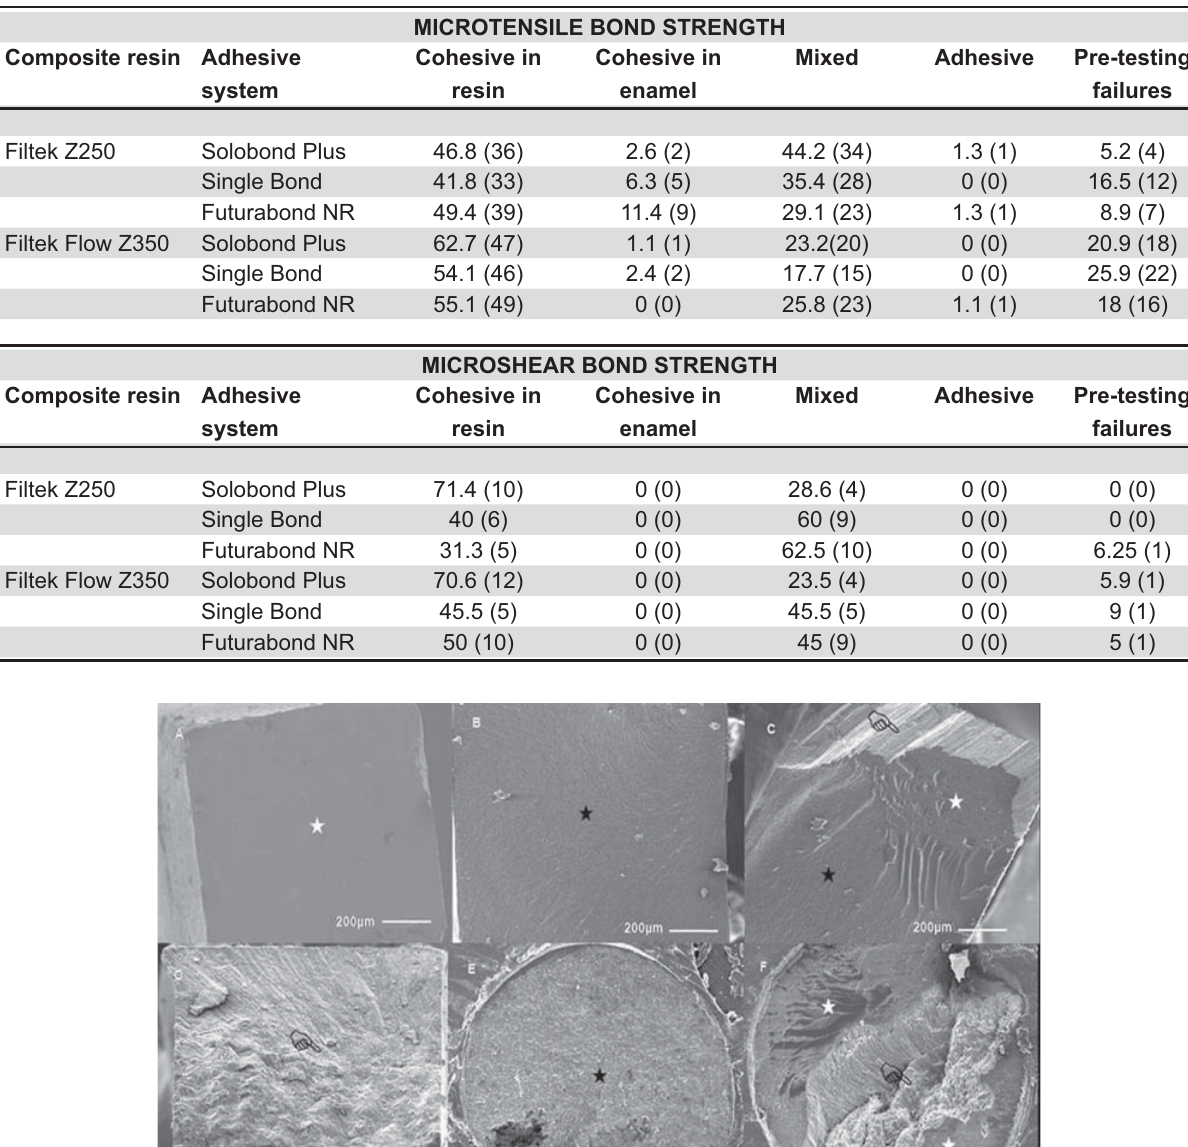
Table 1- Fracture pattern mode (%) and percentage of pre-testing failures according to each experimental